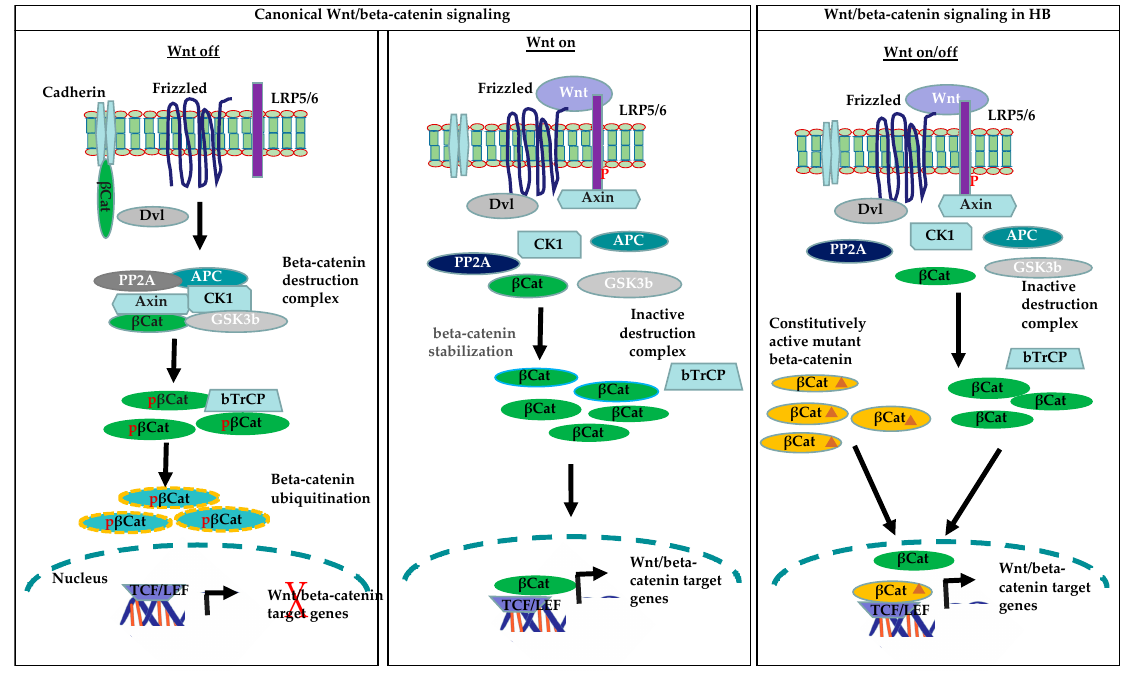
Figure 2. Canonical Wnt / beta-catenin and constitutively active beta-catenin signaling in HB ( β -Cat: beta-catenin; p β -Cat: phosphorylated beta-catenin; β -Cat: mutated beta-catenin)